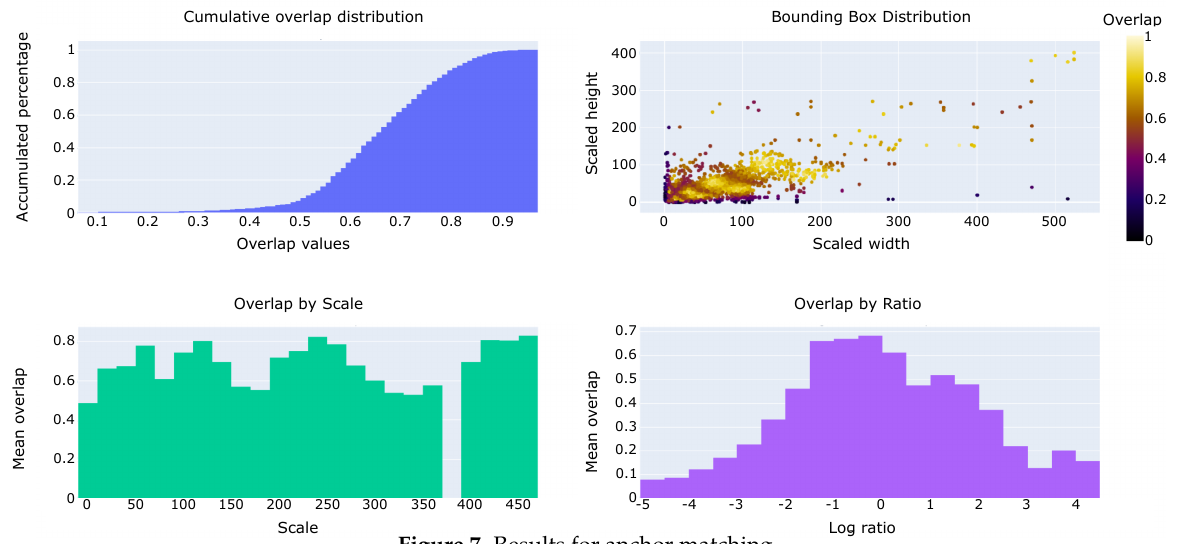
Figure 7. Results for anchor